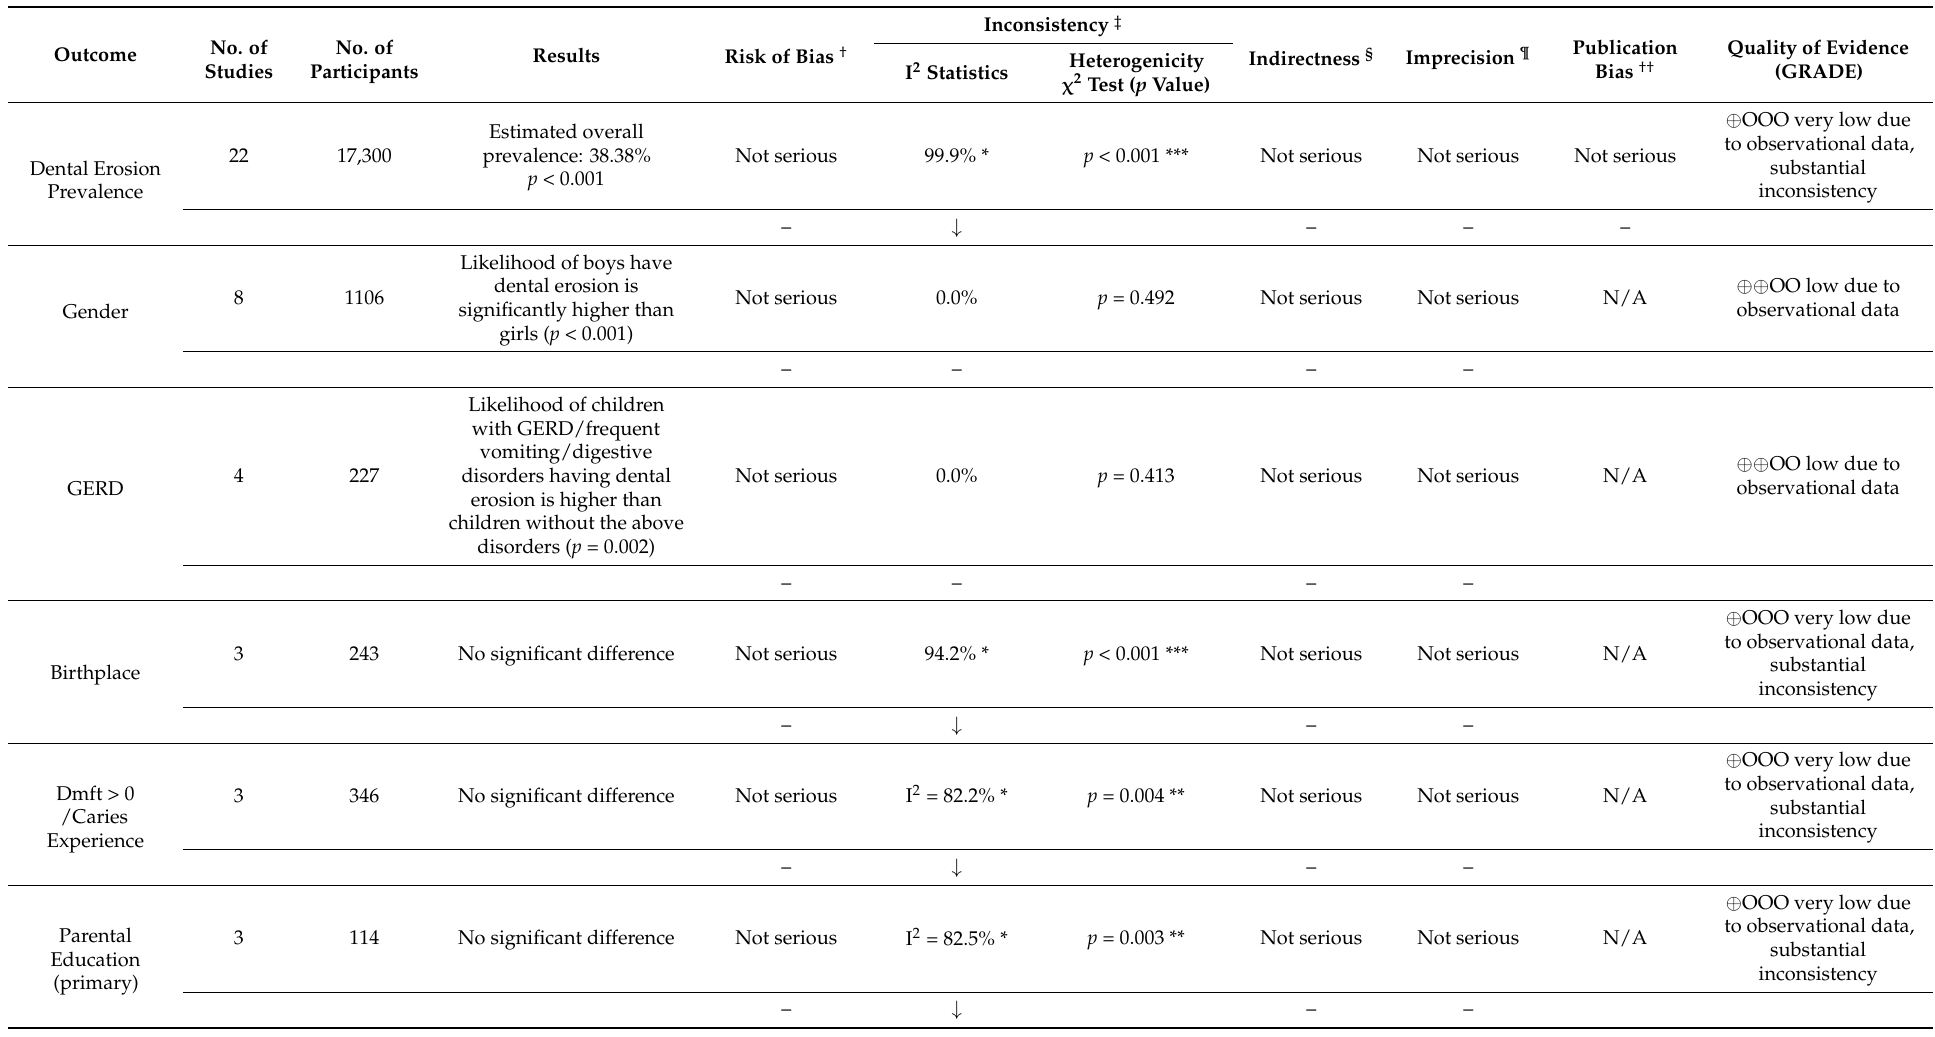
Table 3. GRADE summary of